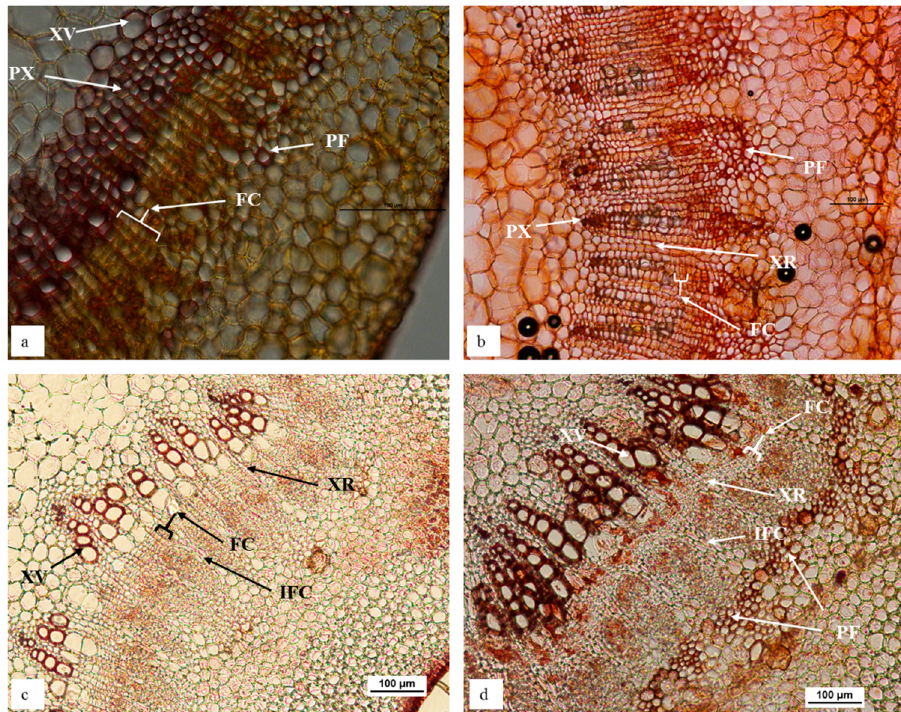
Figure 1. In vitro ‘Reed’ stem is comprised of prominent continuous fascicular cambium, negligible amount of sclerenchymatous phloem fibres and large vessel elements in primary xylem tissues ( a ), in contrast to in vitro ‘Velvick’, which displayed a staggered fascicular cambium, highly abundant with phloem fibre and lesser amount of large vessel elements in primary xylem ( b ). Softwood stem of ‘Reed’ had wider continuous fascicular cambium with no phloem fibre ( c ), while ‘Velvick’ possessed comparatively narrow continuous fascicular cambium and a nearly complete ring of phloem fibre ( d ). Sections obtained from avocado stem at 2.5 cm below the shoot tip: in vitro stem of ‘Reed’ ( a ), in vitro stem of ‘Velvick’ ( b ), softwood stem of glasshouse mature plant ‘Reed’ ( c ), softwood stem of glasshouse mature plant ‘Velvick’. Stems were embedded in agar, sectioned at 50 µm, cleared with chloral hydrate and stained with Safranin O ( n = 5). PX = primary xylem, XR = xylem ray, FC = fascicular cambium, IFC = inter-fascicular cambium, PF = phloem fibre, XV = xylem vessels.